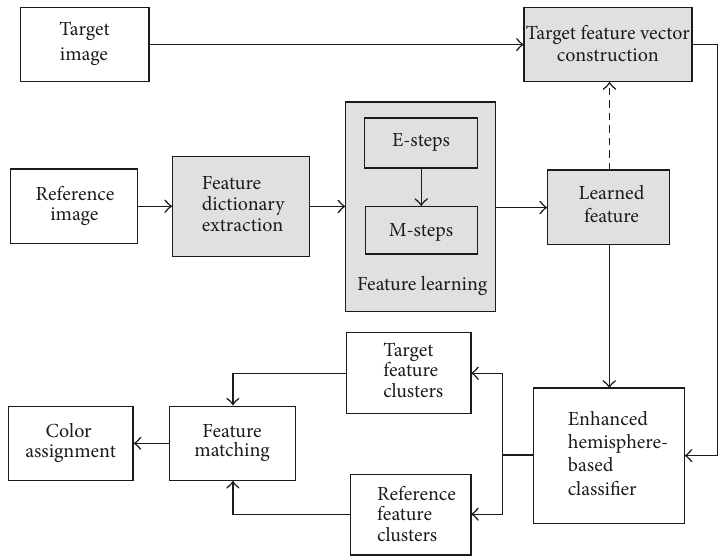
Figure 1: Complete system diagram for colorization using learned feature